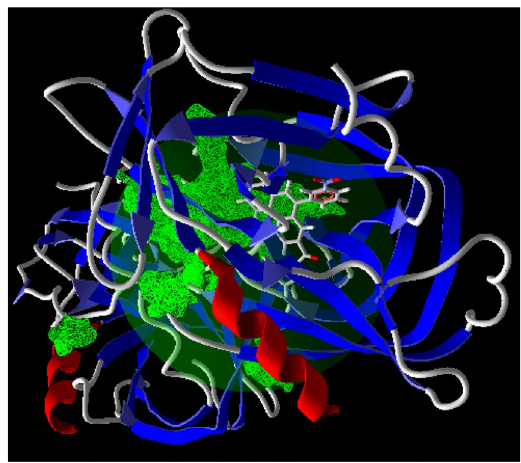
Figure 4. The potential ligand binding cavities of Hepatitis virus.